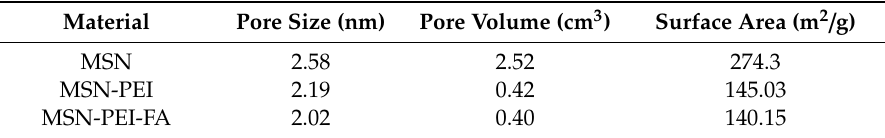
Table 2. The effect of different curcumin dosages on encapsulation efficiency and loading efficiency.